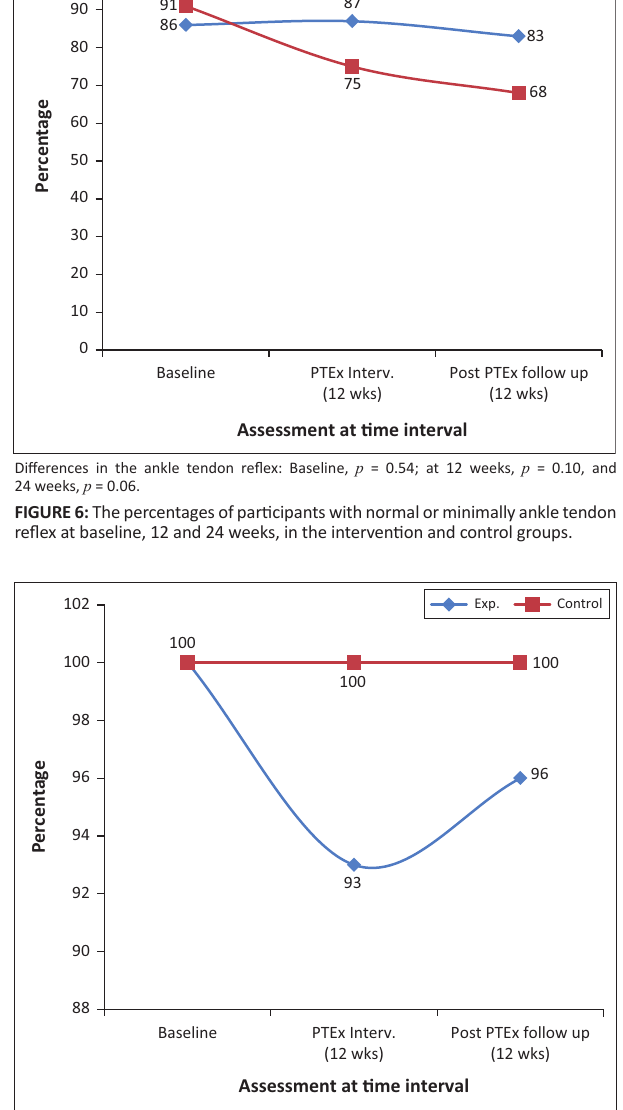
FIGURE 5: The percentages of participants with normal or minimally reduced vibration sense at baseline, 12 and 24 weeks, in the intervention and control groups.